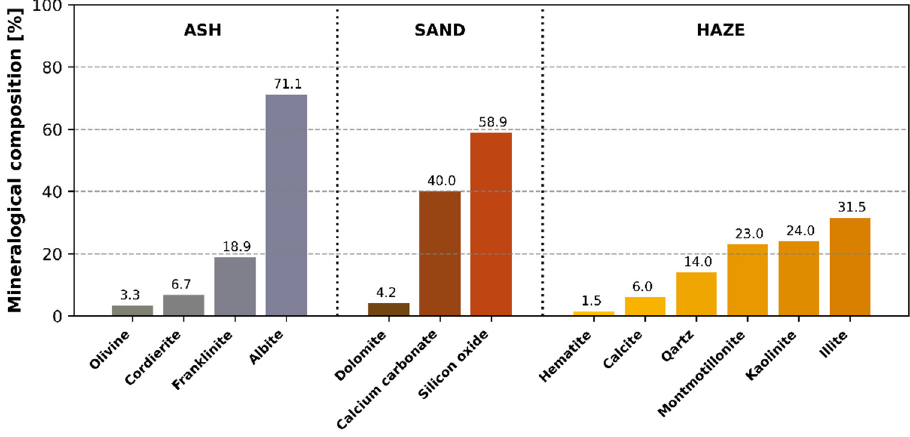
Figure 7. Mineralogical composition obtained from XRD analysis (% volume) for ash, sand, and haze particles (acetoguanamine not included).